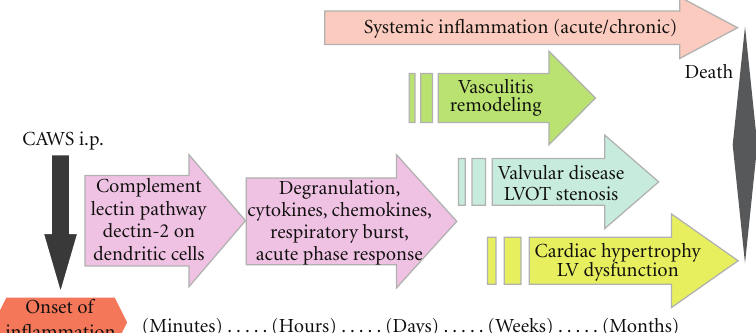
Figure 8: Summarized time course of CAWS-induced systemic inflammation and